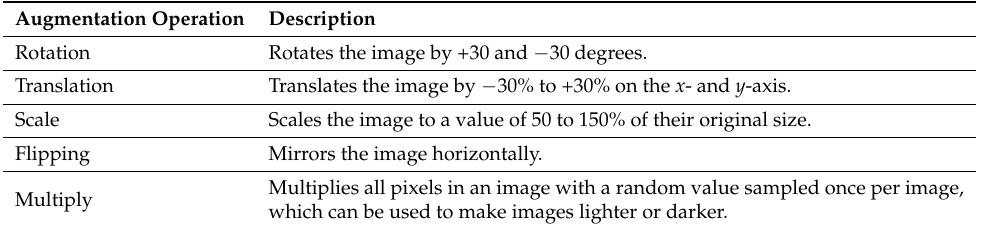
Table 2. Description of the augmentation operations used to expand the original collection of data. Augmentation Operation Description